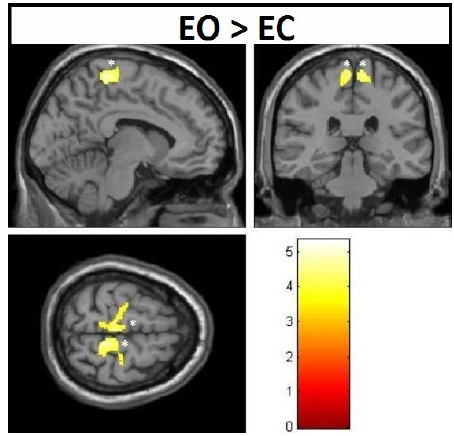
Figure 2. Voxel-based morphometry (VBM)-observed gray matter (GM) increments—group*time interaction effects from pre-test to post-test; * family-wise-error (FWE)-corrected.